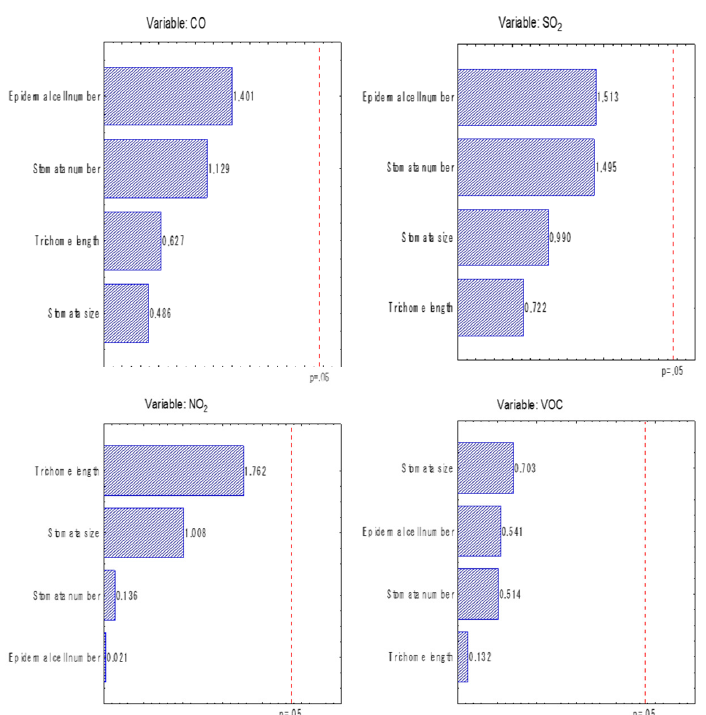
Figure 4. Pareto chart of t-values for coefficients from multiple regression for Polyalthia longifolia